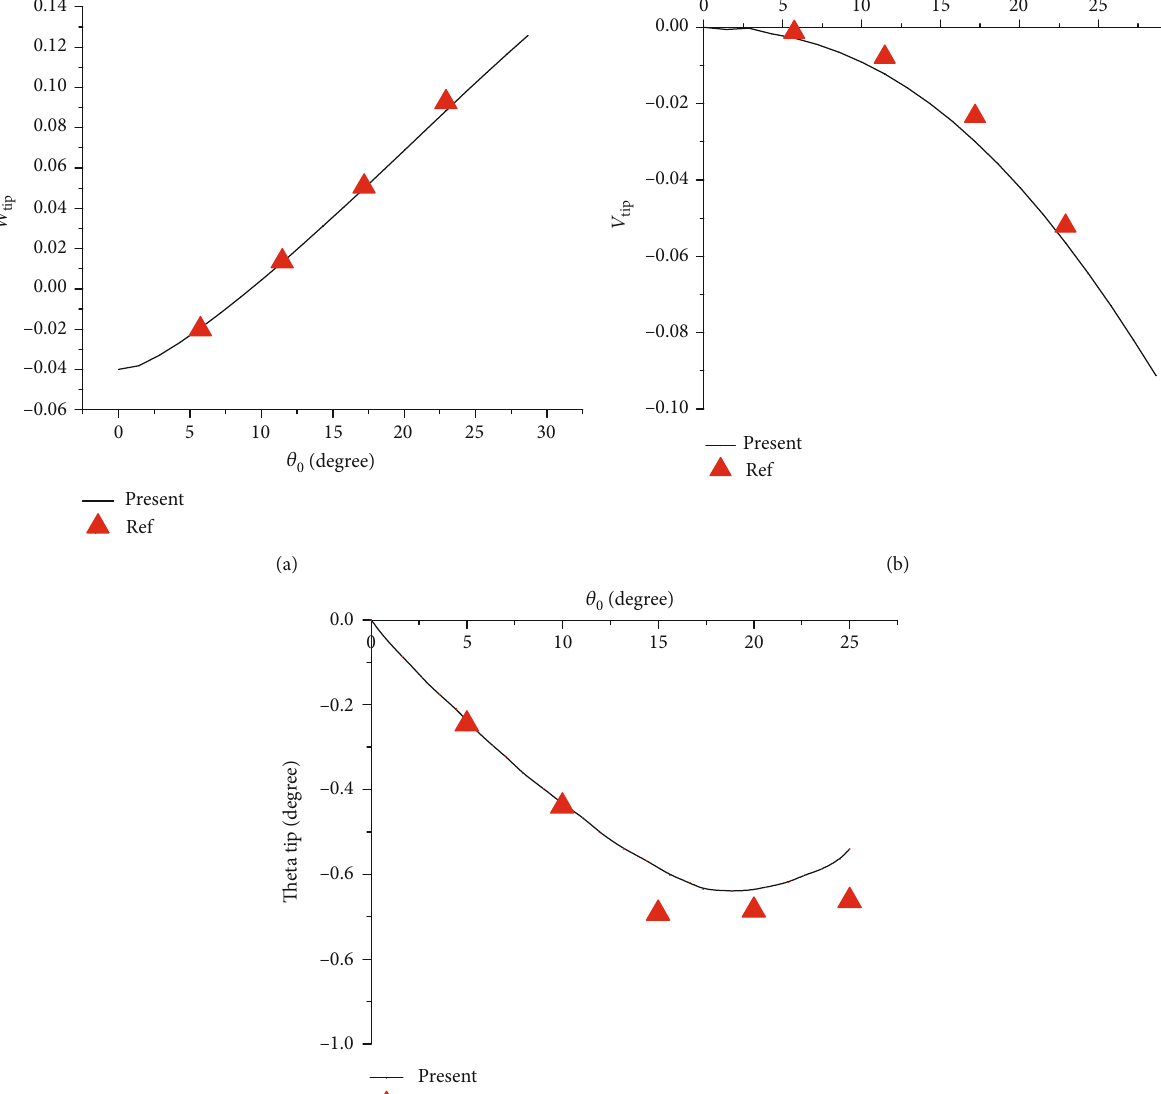
Figure 1: Comparison of steady tip de fl ection by the MDLM and the quasisteady strip theory ( ω